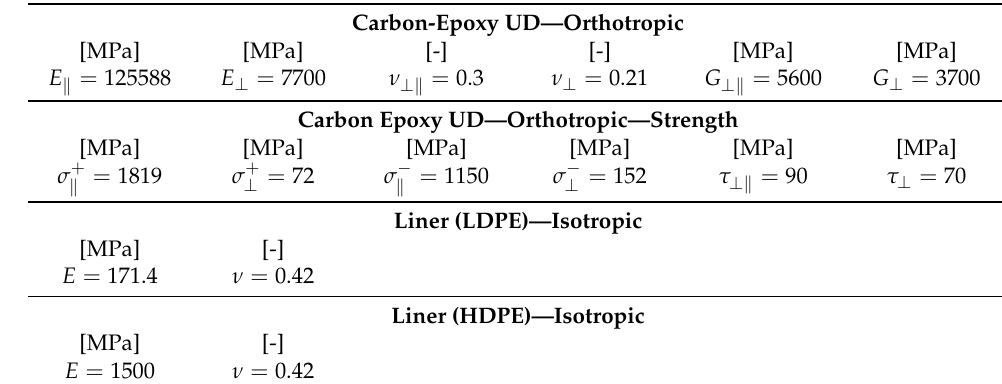
Table 1. Material parameters